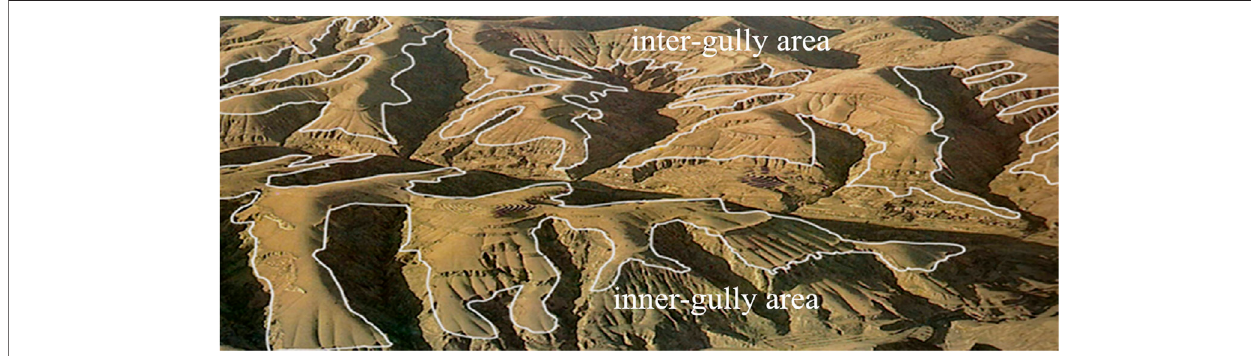
FIGURE 1 | Illustration of loess shoulder-lines on surface (Yan et al., 2014).